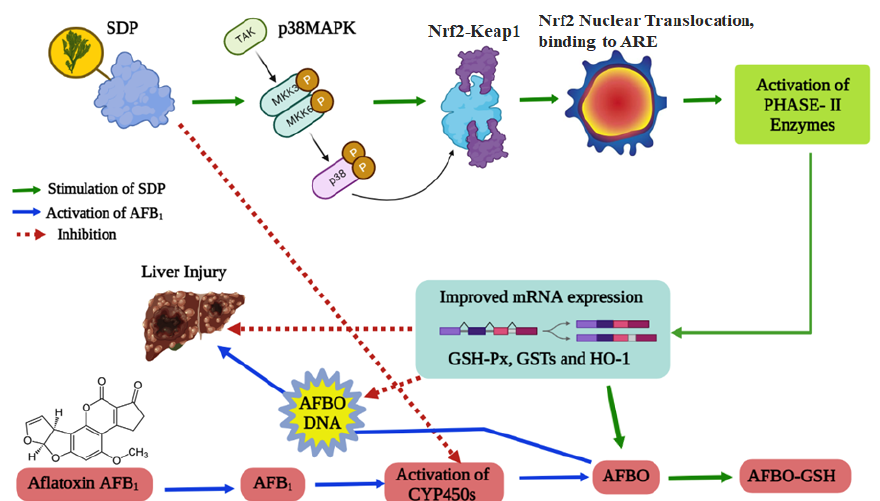
Figure 8. Proposed model of the protective effects of seaweed ( Enteromorpha prolifera )-derived pol- polysaccharides against aflatoxin B 1 -induced hepatotoxicity in broiler ysaccharides against aflatoxin B 1 -induced hepatotoxicity in broiler chickens.